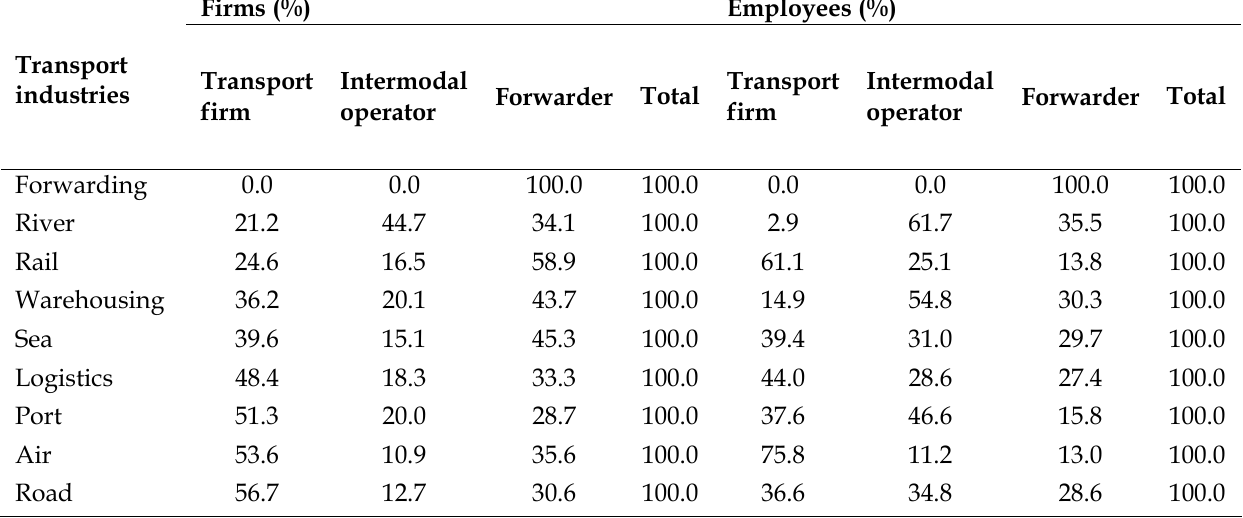
Table 5. Distribution of transport industries by types of firms Firms (%) Employees (%)